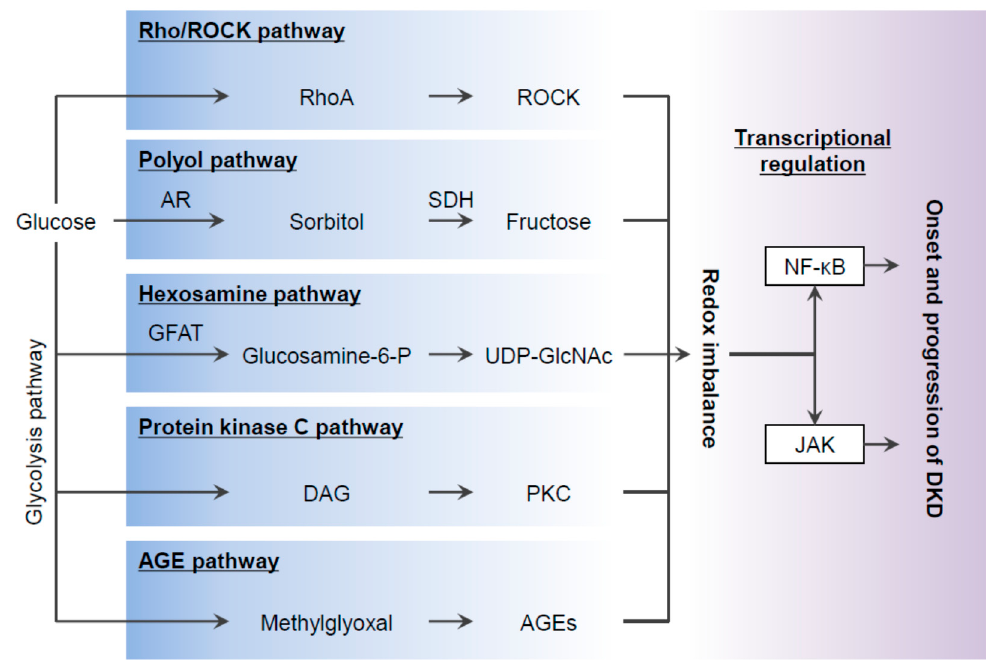
Figure 1. In the setting of diabetes, excess glucose activates several pathways including the polyol pathway, hexosamine pathway, as well as signals that lead to activation of Rho-kinase (ROCK), PKC and generation of AGEs. All of these activation results in oxidant / antioxidant imbalance that proceeds to DKD. AR, aldose reductase; SDH, sorbitol dehydrogenase; GFAT, glutamine:fructose-6-phosphate aminotransferase; glucosamine-6-P, glucosamine-6-phosphate; UDP-GlcNAc, uridine diphosphate-N-acetyl glucosamine; DAG, diacylglycerol; PKC, protein kinase C; AGEs, advanced glycation end-products.